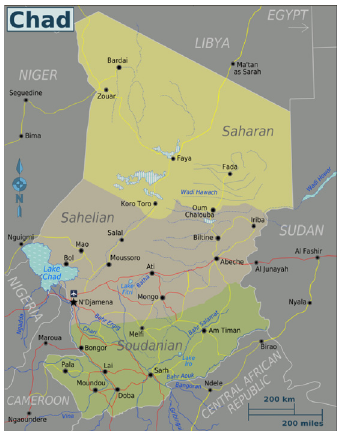
Figure 1: Geographical map of Chad